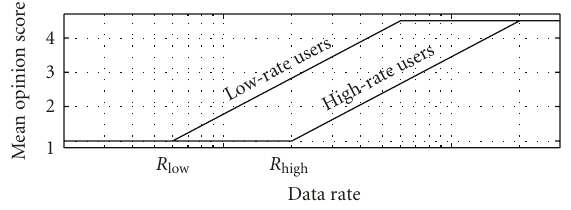
Figure 14: Example characteristic for two user groups running di ff erent application classes.